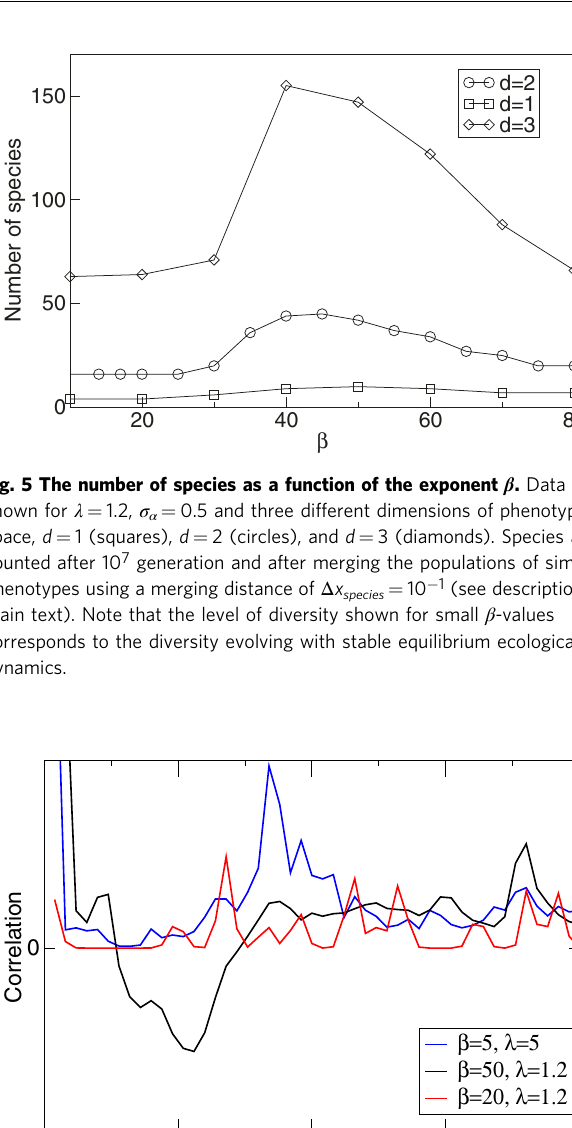
Fig. 6 Correlation between population sizes of different phenotypes. The correlation between phenotypes x and y , C xy ≡ 〈 ( N x ( t ) − 〈 N x 〉 )( N y ( t ) − 〈 N y 〉 ) 〉 , is shown as a function of phenotypic distance ∣ x − y ∣ for β = 50, λ = 1.2 (black line), β = 20, λ = 1.2 (red line) and β = 5, λ = 5 (blue line). Dimension of phenotype space is d = 2, and σ α = 0.5. The correlation was calculated by taking into account all possible pairs of phenotypes over 5×10 6 generations after the steady state level of diversity was reached. Anti-synchronization is only seen for boom-bust dynamics (black) allowing for increased diversity (cf. Fig. 3), but not for higher frequency chaotic dynamics with small (red) or large (blue) amplitudes.